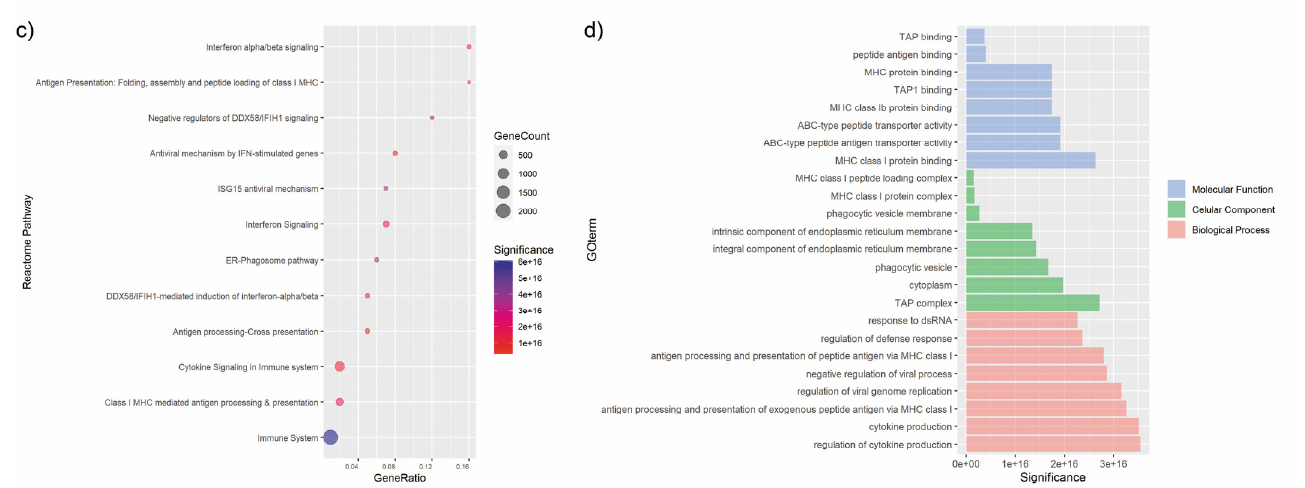
Figure 2. mRNA modulation during immunogenic cell death. Mantle cell lymphoma (MCL: Mino) and breast cancer (BC: MDA-MB-231) cell lines were treated with two ICD-inducers: 9-cis Retinoic Acid and Interferon-alpha (RA/IFN α ) and doxorubicin (DXR) or exposed to not-ICD inducing treat- ment with gamma irradiation (gIrr). RNA-seq was performed through NGS technology. ( a , b ) UpSet plots of mRNA differentially downregulated ( a ) and upregulated ( b ) between control and treatments. The significance of gene expression changes was inferred based on an adjusted p -value < 0.5 and FC ≤ − 1.3 ( a ) or FC ≥ 1.3 ( b ). The blue ( a ) and orange ( b ) horizontal bars on the left show the number of differentially expressed genes identified by each treatment vs. untreated cells, ordered by set size. The vertical bars display the size of sets of genes shared between comparisons and the intersection sets. The interaction between ICD inducers excluding not-ICD inducing treatment is highlighted in blue ( a ) or in orange ( b ). ( c ) Bubble plots showing overrepresented Reactome pathways in upregulated genes by ICD inducers. The y -axis represents the significantly enriched pathways, the x -axis represents the gene ratio (intersection size/term size), the size of the bubbles represents the number of assigned genes, and the color of bubbles represents the significance (negative log10 p -value). The larger number of genes classified into the pathway, the larger the node size is. ( d ) Bar plot of enriched gene ontology (GO) terms of upregulated genes by ICD. Y -axis indicates the GO term, x -axis indicates the significance (negative log10 p